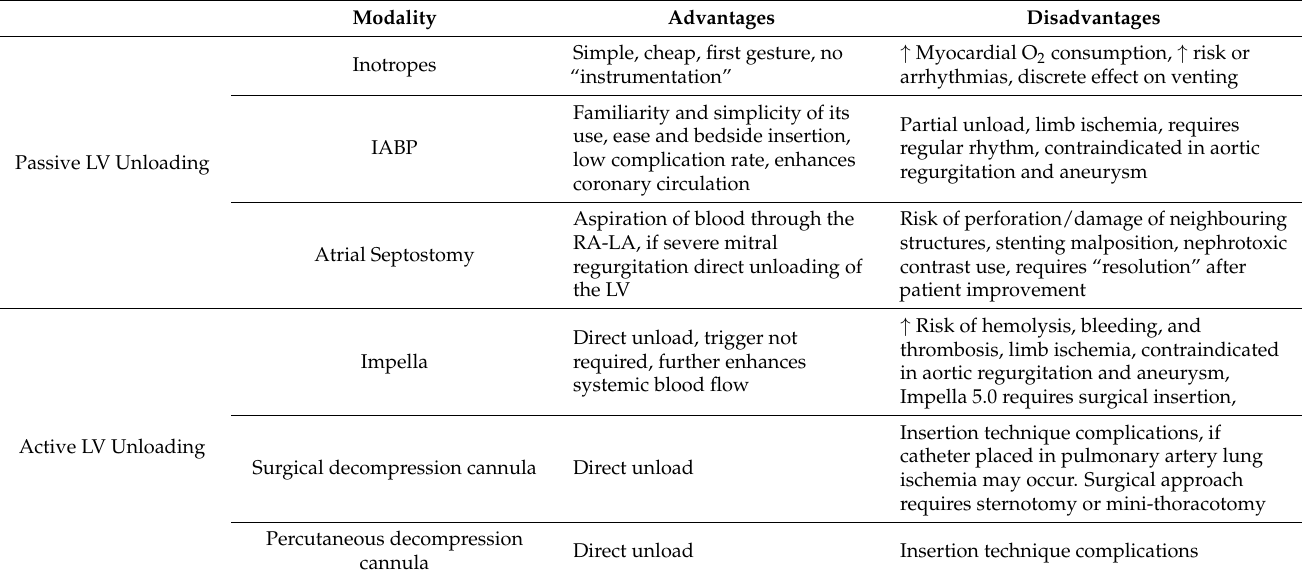
Table 2. Comparative effects of venting